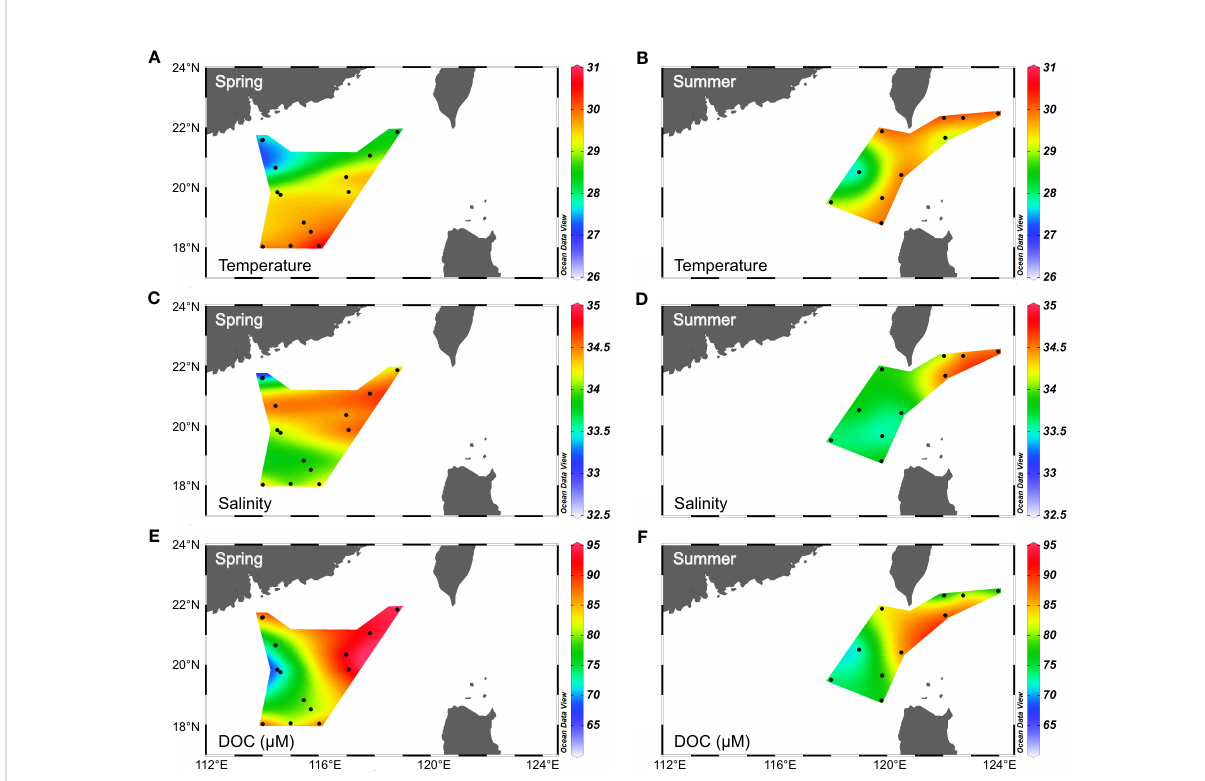
FIGURE 5 Surface distribution ( ≤ 15 m water depth) of (A, B) temperature (°C), (C, D) salinity and (E, F) DOC ( m M) in the northern SCS and western North Paci fi c during spring (A, C, E) and summer (B, D, F) in 2015-2016 and 2019. For comparison, the hydrographic data and DOC concentrations at